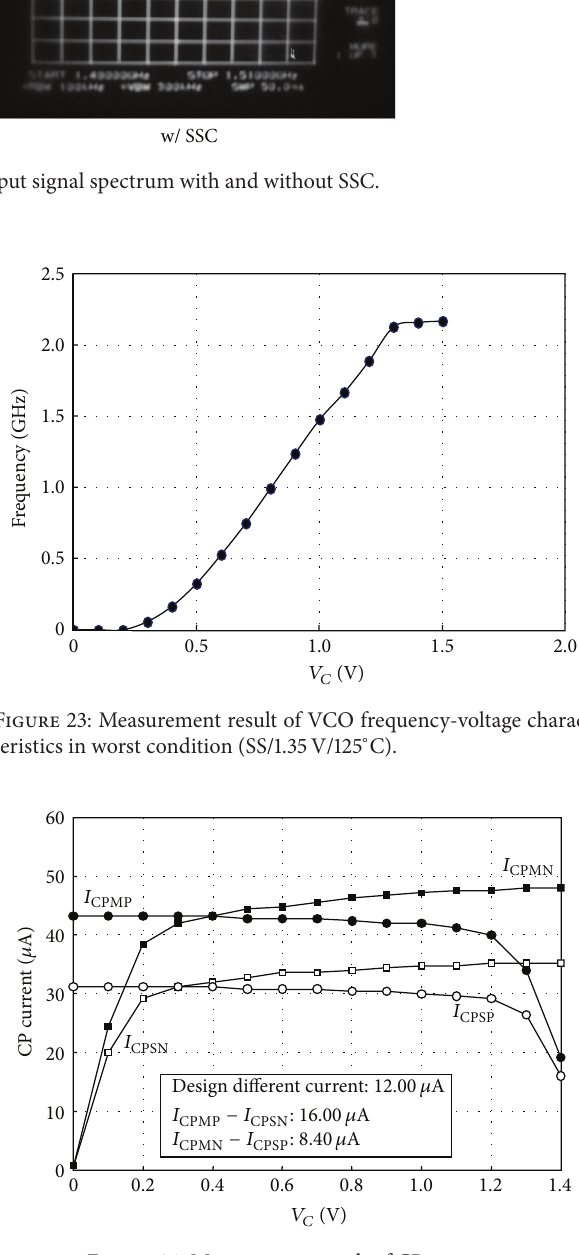
Figure 24: Measurement result of CP